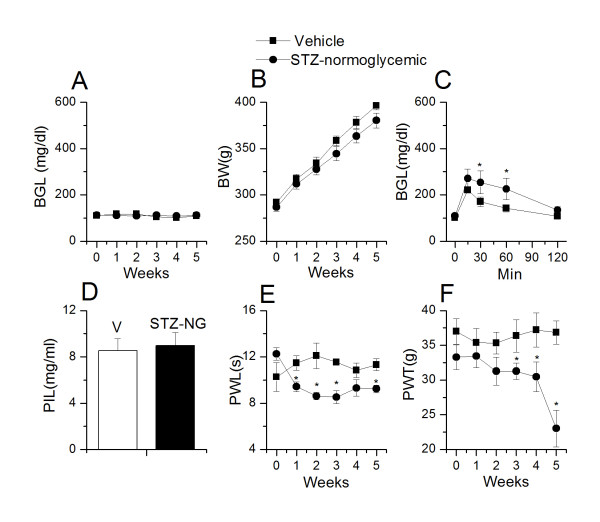
Changes in blood glucose levels, body weight, glucose tolerance, plasma insulin levels, thermal pain sensitivity, mechanical allodynia in STZ-treated normoglycemic (STZ-NG) rats. A. Blood glucose levels (BGL) remained constant throughout the course of the experiment in STZ-NG and vehicle-treated rats. B. The body weight of STZ-NG rats (filled circles, n = 12) and vehicle-treated rats (filled squares, n = 10) increased steadily over the course of 5 weeks C. Glucose tolerance test (GTT) in STZ-NG and vehicle-treated rats after 5 weeks of STZ administration. D. Plasma insulin levels were unchanged in STZ-NG rats as compared to vehicle-treated rats. E. STZ-NG rats exhibited a significant decrease (p < 0.05) in PWL as compared to vehicle-treated rats. F. STZ-NG rats exhibited a significant (p < 0.05) decrease in PWT after 3 weeks of STZ administration as compared to vehicle-treated rats. Asterisk (*) represent p < 0.05.